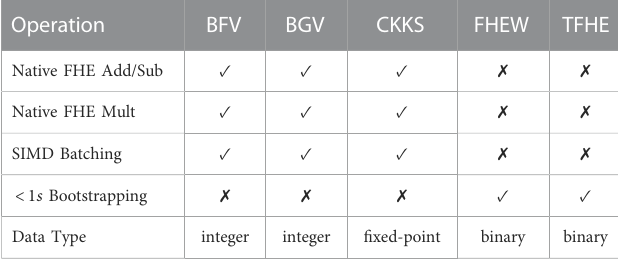
TABLE 1 The comparison of FHE schemes.